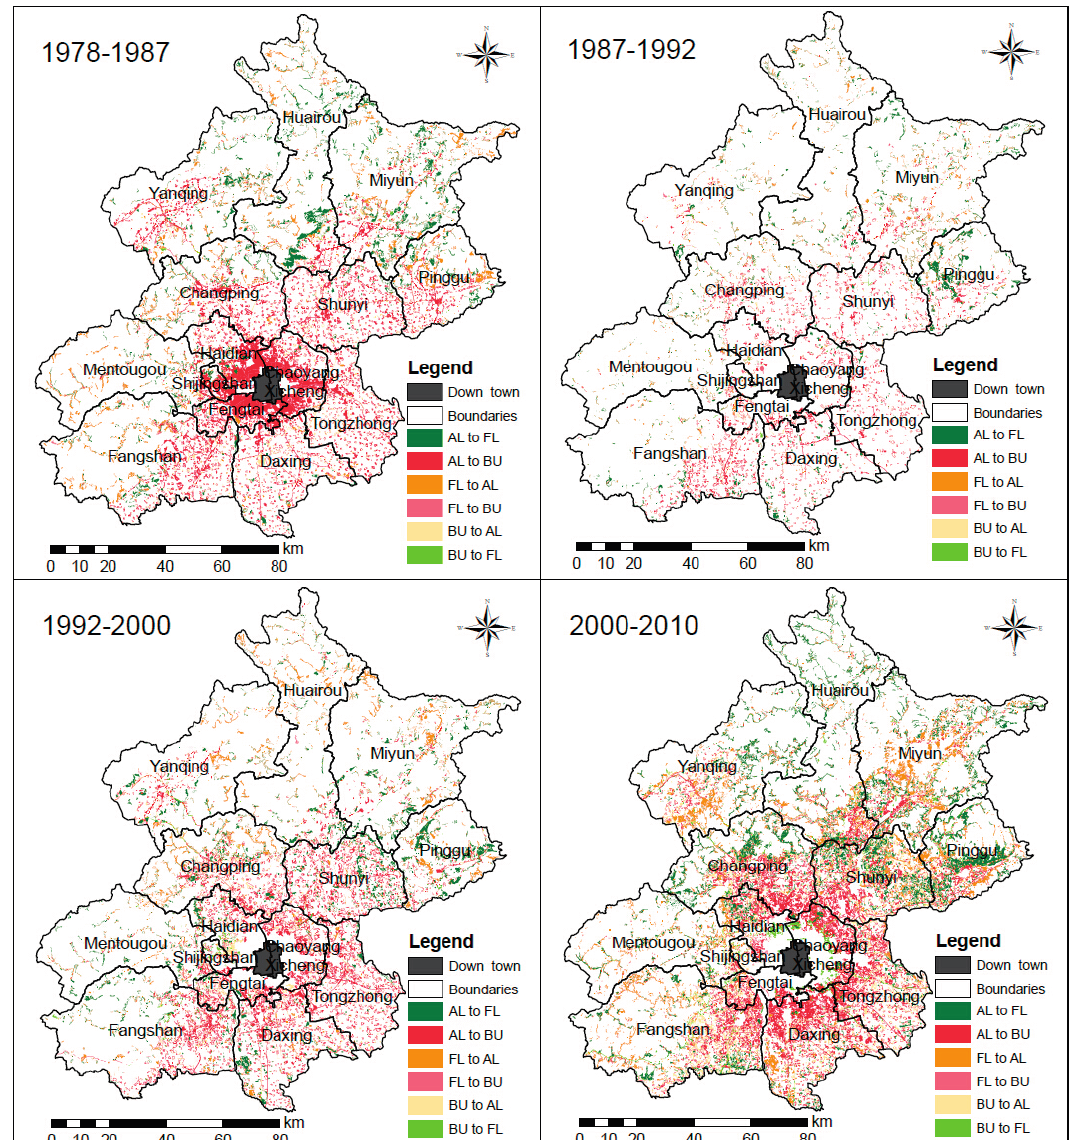
Figure 4. Beijing land use and land cover change maps at the per-pixel scale for four